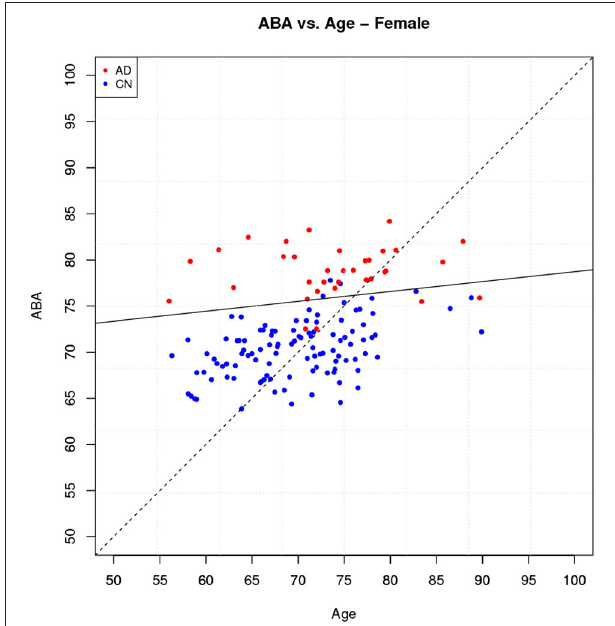
FIGURE 7 | Holdout method: ABA vs. Age plot for the female gender group.